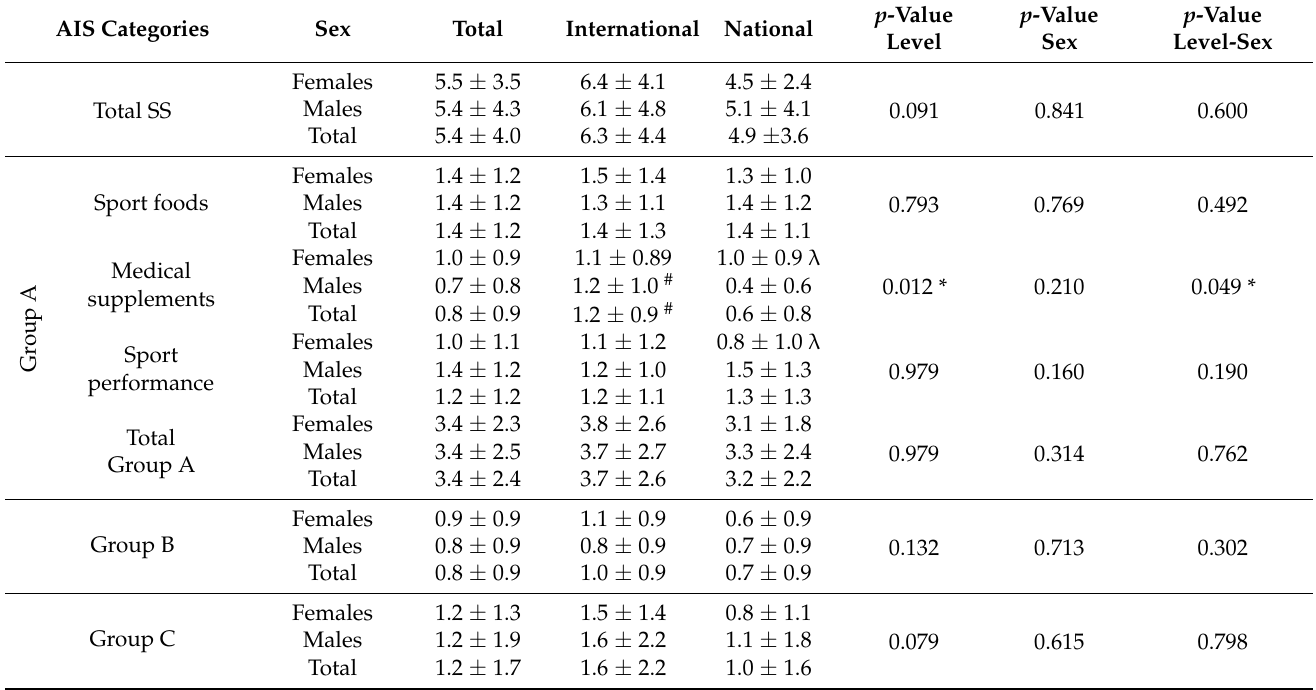
Table 2. Number of SSs used by swimmers of both sexes and at different competitive levels according to AIS categories [21].